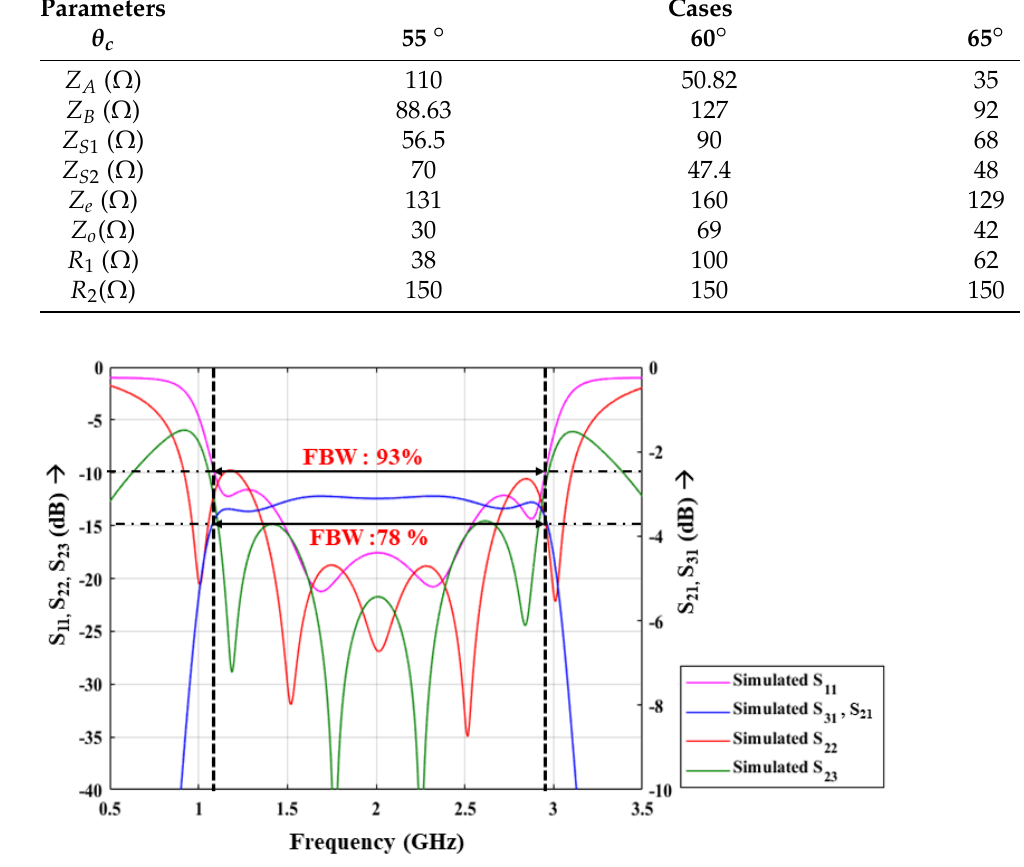
Figure 19. Simulated S − parameters (dB) for θ c = 55 ◦ .